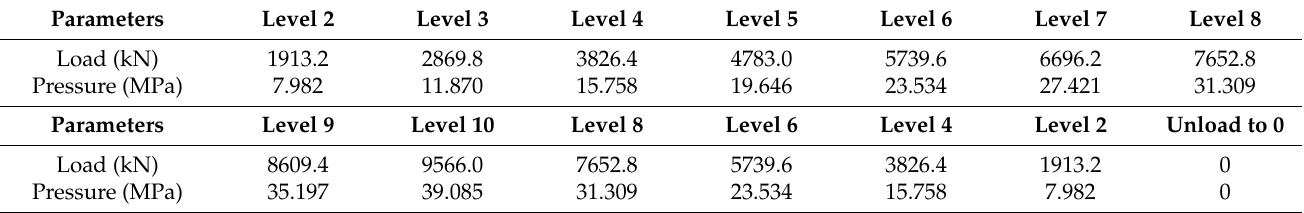
Table 3. Loading and unloading capacity at all levels and oil pressure of lifting jack in a vertical compressive static load